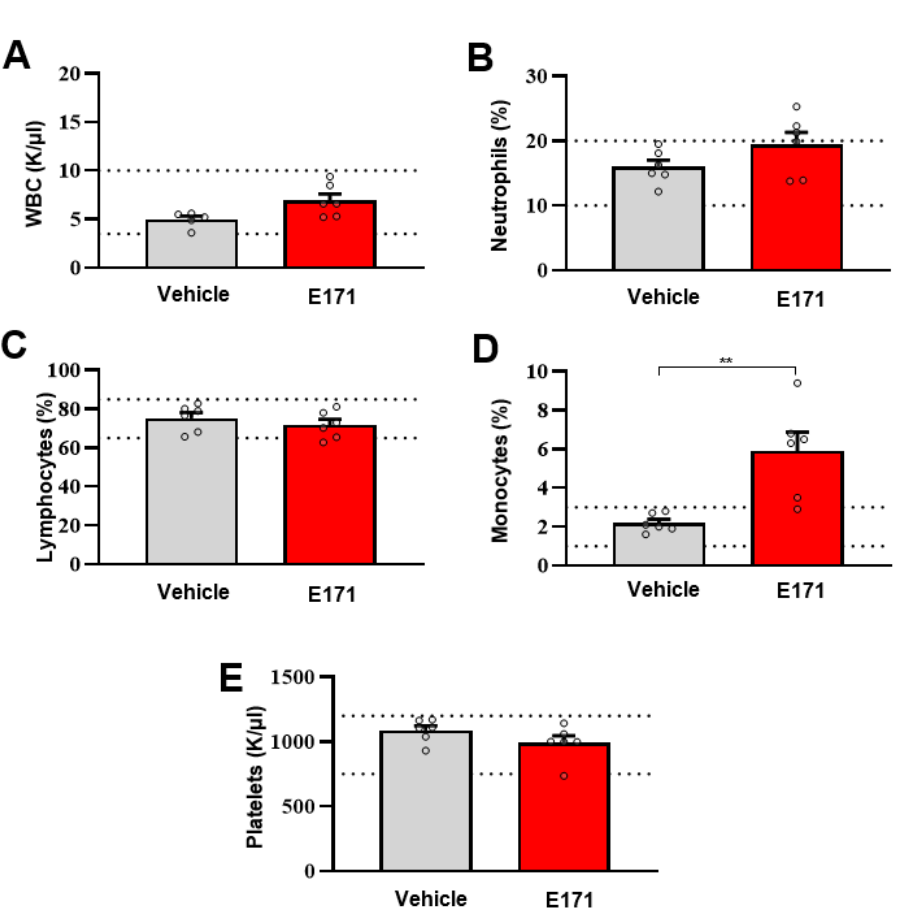
Figure 4. Effect of E171 on complete blood cell count. ( A ) Total white blood cells (WBC), ( B ) neutrophils, ( C ) lymphocytes, ( D ) monocytes, and ( E ) platelets of mice, measured 12 h after the intravenous injection of E171. Control mice were treated with vehicle alone (Vehicle). The dotted lines indicate the upper and lower normal values for each variable (4–10 K/ μ L for WBC; 65–87% for lymphocytes; 10–20% for neutrophils; 1–3% for monocytes; and 750–1250 K/uL for platelets). Data are given as mean ± SEM (N = 6); ** p < 0.005 vs . vehicle mice, according to a two-tailed Mann–Whitney test.